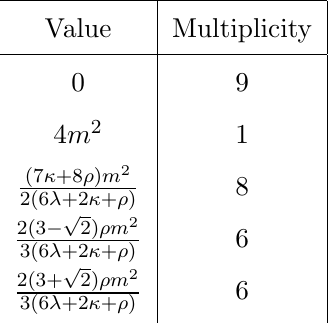
Table 11 . Scalar mass eigenstates for the SSB pattern SU(3) ! PSL(2 ; 7) using a 15 0 of SU(3).